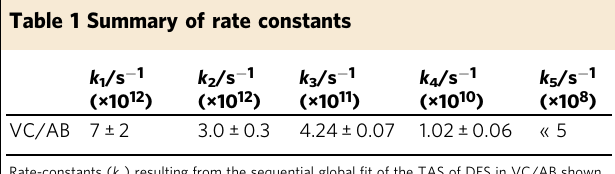
Fig. 4 Endocrine disruption assay results. Endocrine disruption activity of DES, as determined by assays on several cell lines, for the alpha oestrogen receptor ER α (circle) as either an agonist (magenta) or antagonist (blue), and for the xenobiotic receptor PXR (square) as either an agonist (green) or antagonist (orange). The activity of ER α is regulated by the steroid and